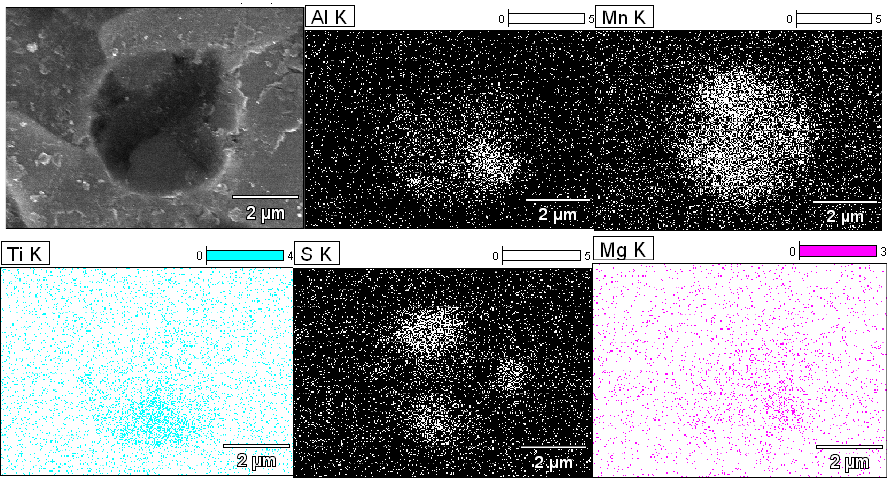
Figure 10. Surface scanning analysis of inclusions that contain Mg.